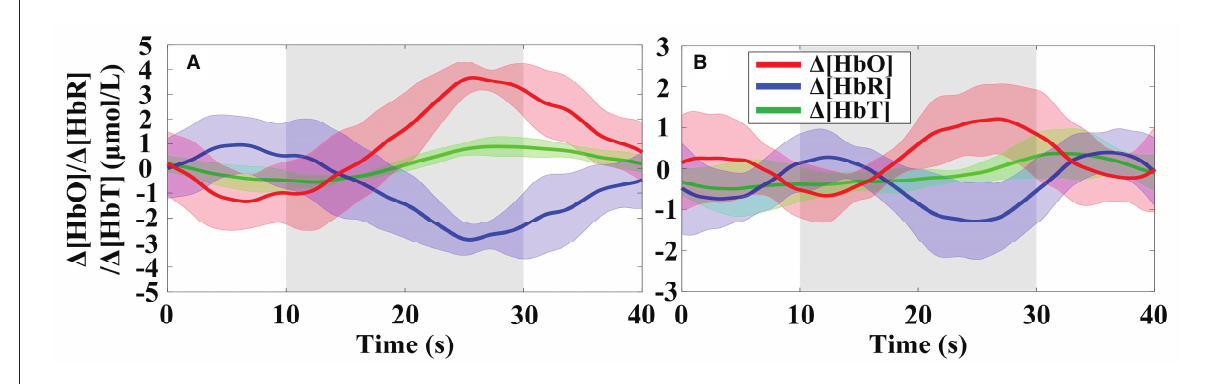
FIGURE9 Trial-averaged hemoglobin concentration changes for participant 1 in the most significantly activated channels: (A) Channel #5 in the MA and (B) channel #6 in the MS were significantly activated. The gray highlighted rectangles indicate the stimulation periods. 1 [HbT] indicates the change in total hemoglobin concentration. The shades of the same color around the curves represent the standard